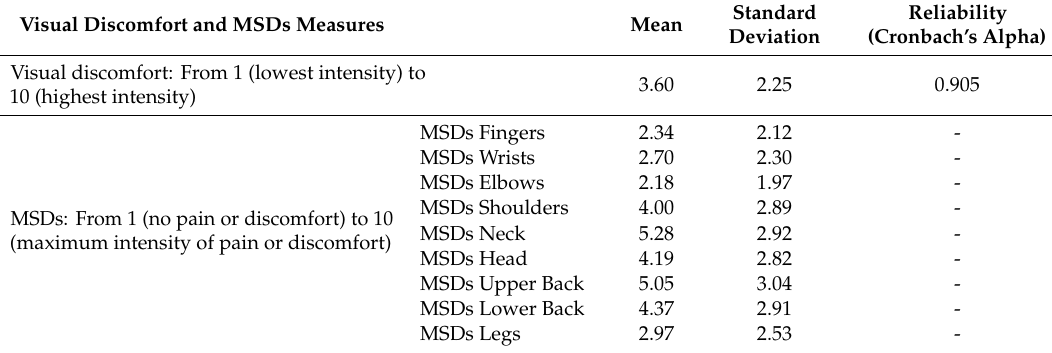
Table 4. Descriptive results (3): Centrality, deviation of Visual discomfort and MSDs measures, as well as reliability indicators of Visual discomfort scale.